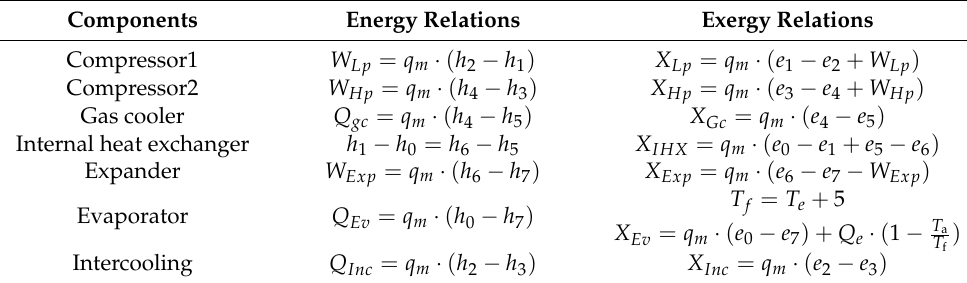
Table 1. Energy and exergy relations for the